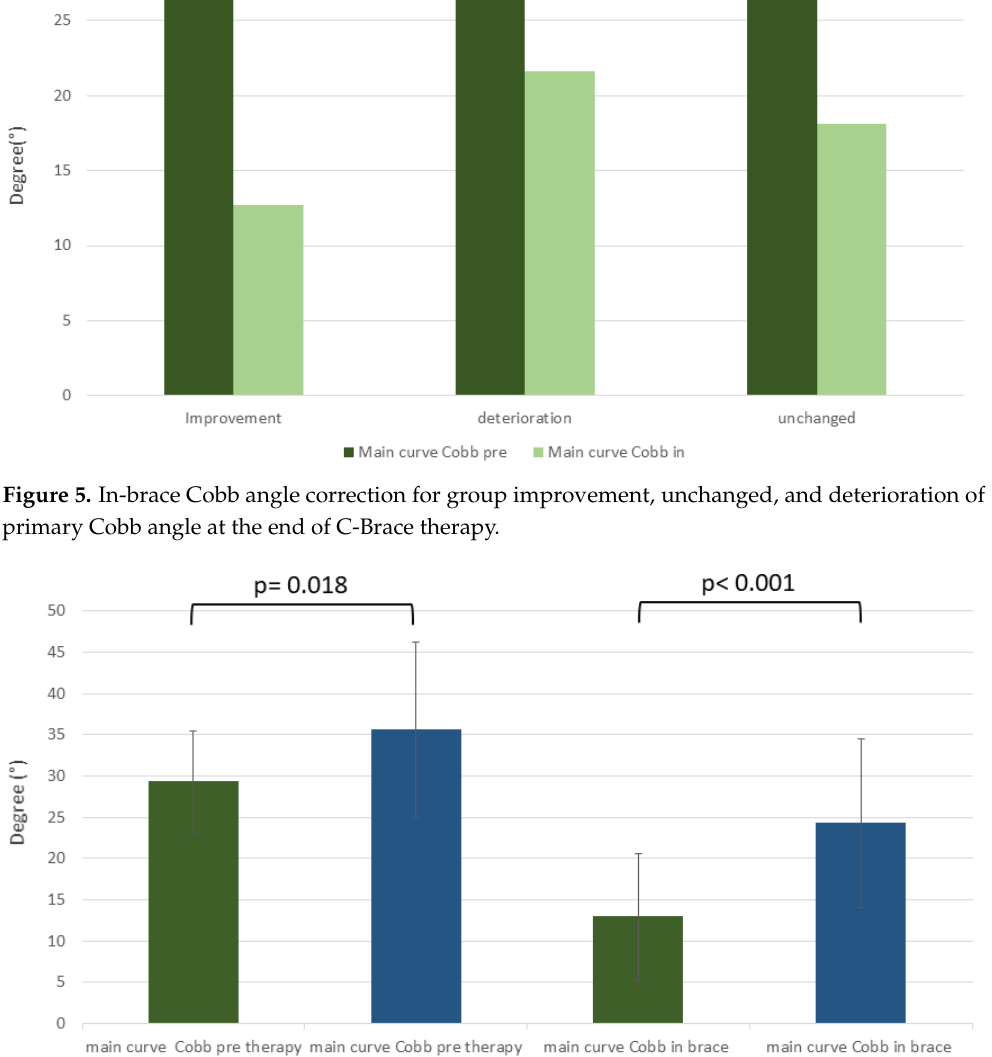
Figure 5. In-brace Cobb angle correction for group improvement, unchanged, and deterioration of primary Cobb angle at the end of C-Brace therapy.